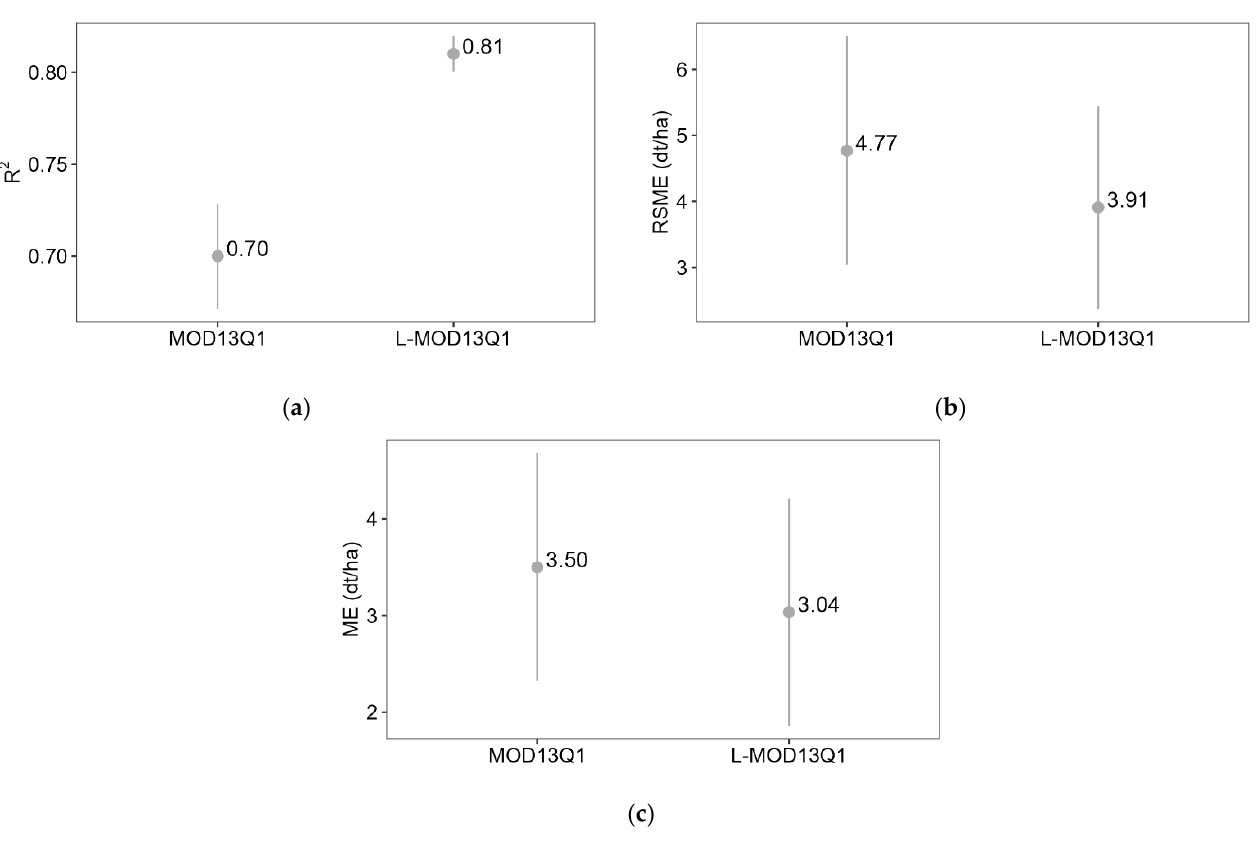
Figure 6. The dot plots compare the accuracies ( a ) R 2 , ( b ) RMSE, and ( c ) ME of referenced data (at 95% confidence intervals) and modelled yields obtained from multi-source data: MOD13Q1 and L-MOD13Q1 in 2019.